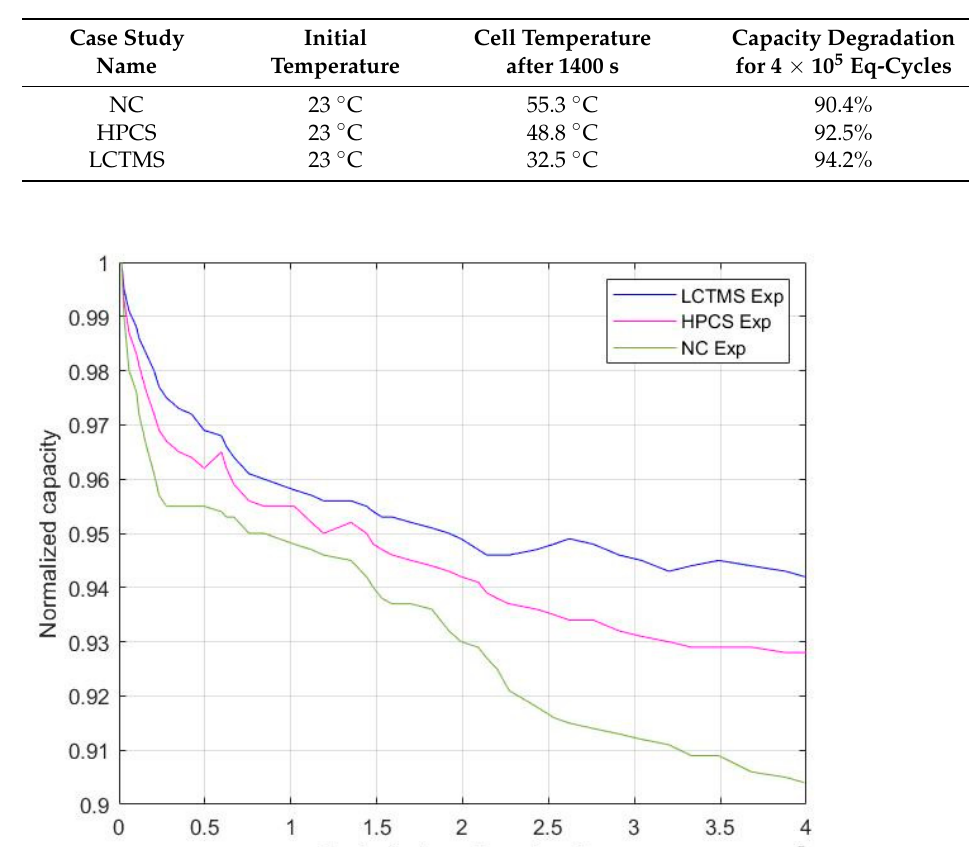
Table 4. Capacity degradation for 4 × 10 5 equivalent cycles for three case studies.